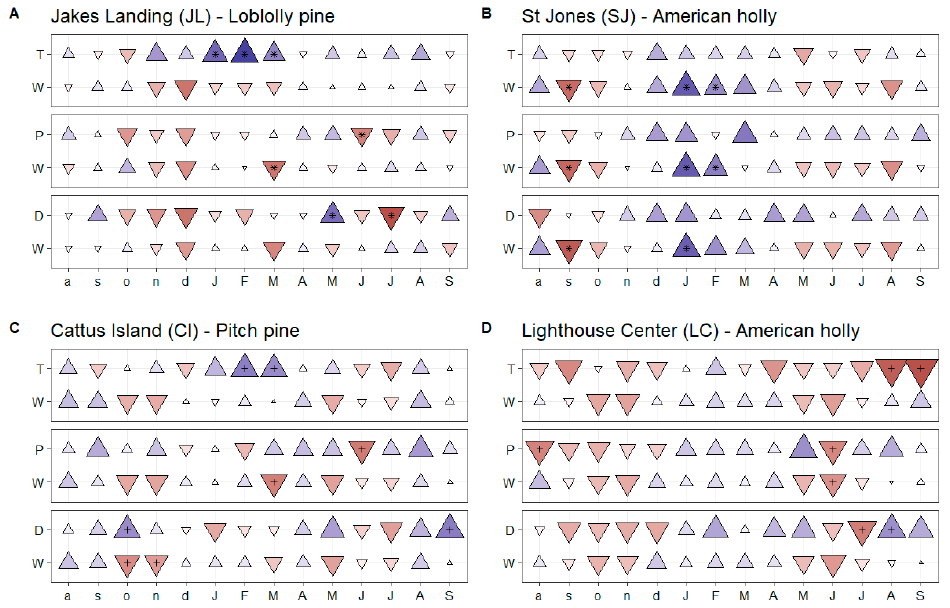
Figure 4. Partial correlation results for ( A ) Jakes Landing loblolly pine, ( B ) St. Jones American holly, ( C ) Cattus Island pitch pine, and ( D ) Lighthouse Center American holly. Pairwise tests were temperature (T), precipitation (P), and drought (D) as primary variables and water levels (W) as secondary variables. Positive correlations are represented by upwards, blue triangles, whereas negative correlations are downwards, red triangles. Saturation and size of symbols reflect the strength of the correlation (i.e., R ), ranging from +0.5 to − 0.5. Significant correlations are noted with a symbol depending on α -level (asterisk for α = 0.05 in ( A , B ), or plus sign for α = 0.1 in ( C , D )). Antecedent months are given using all lower-case letters, whereas concurrent months are given in capital letters.